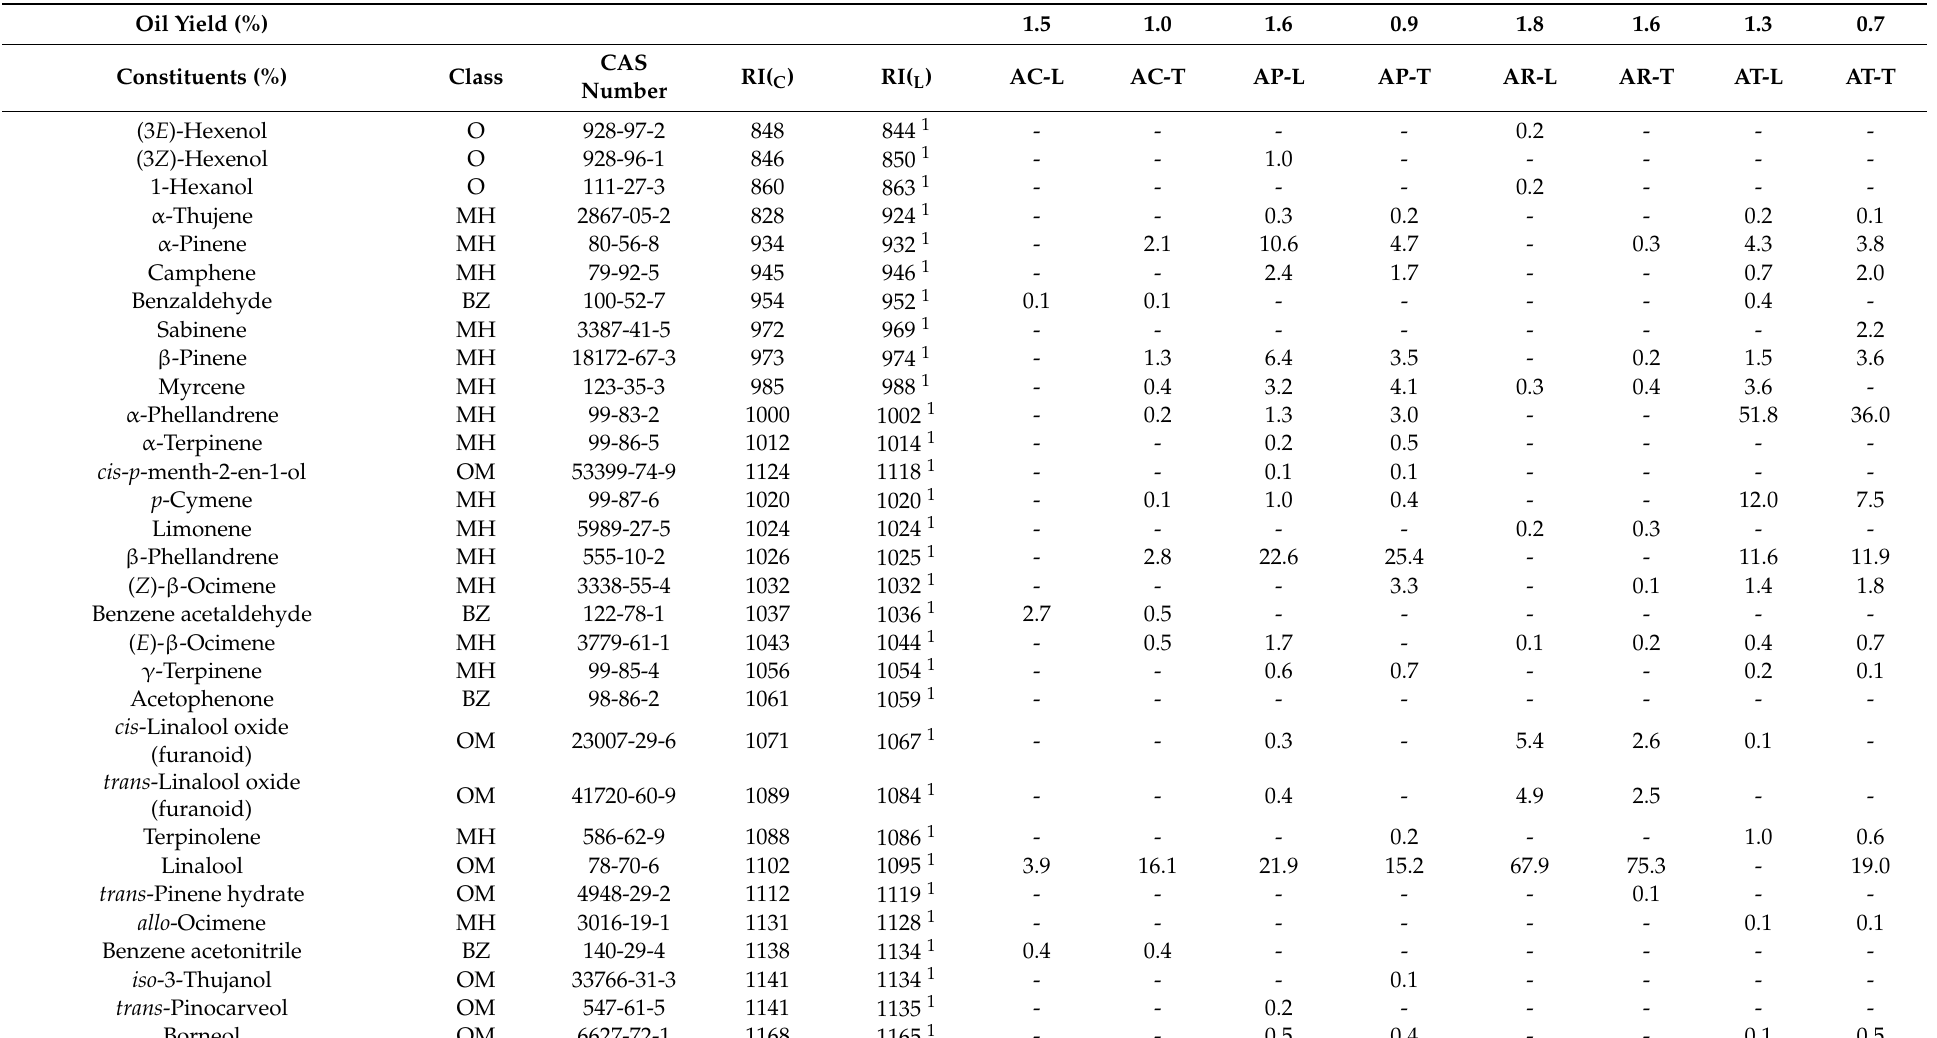
Table 1. Yield and volatile composition of the Aniba essential